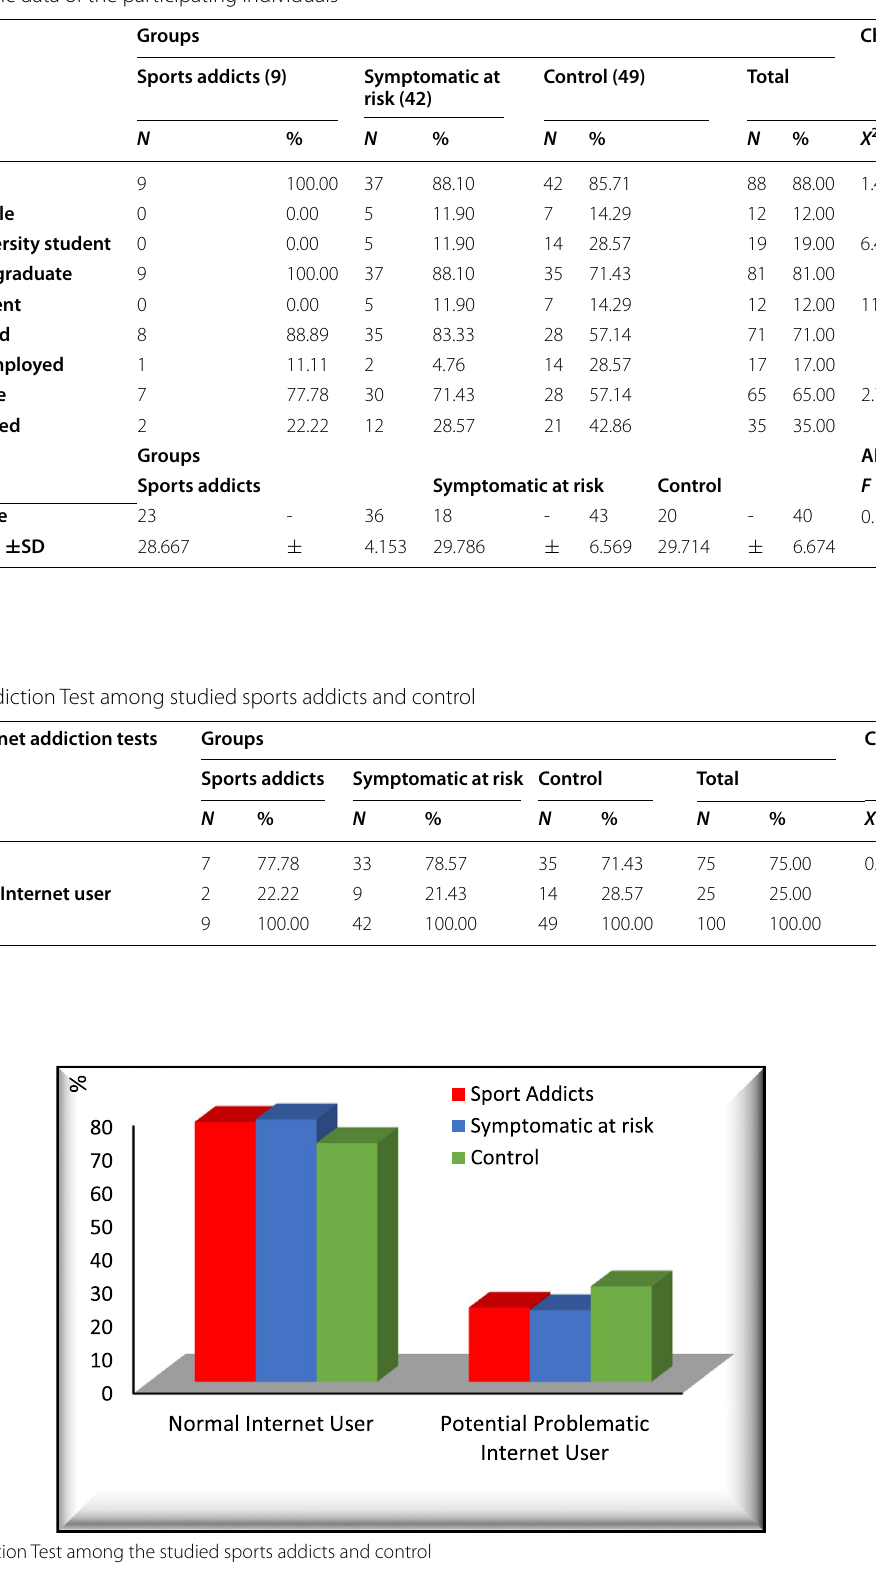
Table 1 Demographic data of the participating individuals